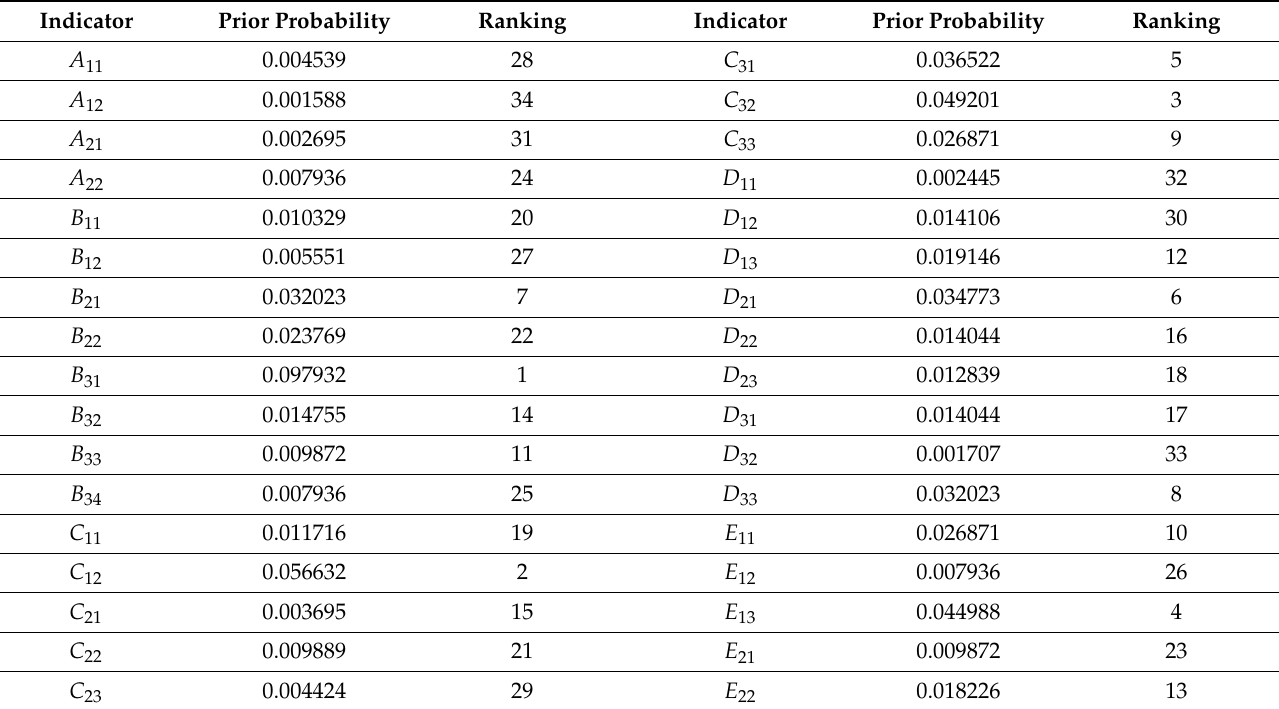
Table 6. Prior probability and ranking of all nodes.